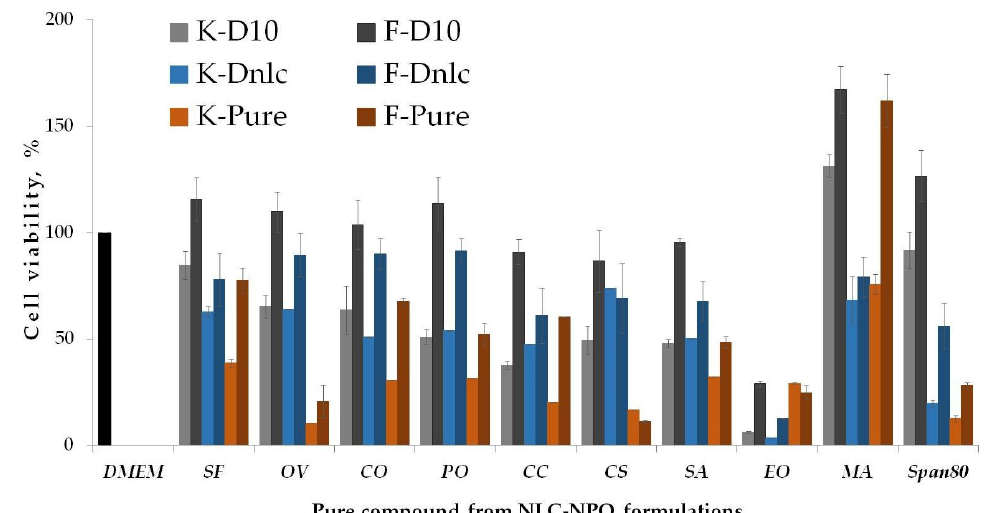
Figure 7. Cytotoxicity of compounds involved in NLC-NPO formulations on dermal cells; K—keratinocytes (HaCaT), F—fibroblasts (HDFn); Dnlc—concentration in final formulation; D10—dilution 10 of Dnlc; Pure compounds were taken in their original form. Medium (DMEM) was used as comparison (positive control) (mean value ± SD; n = 3).